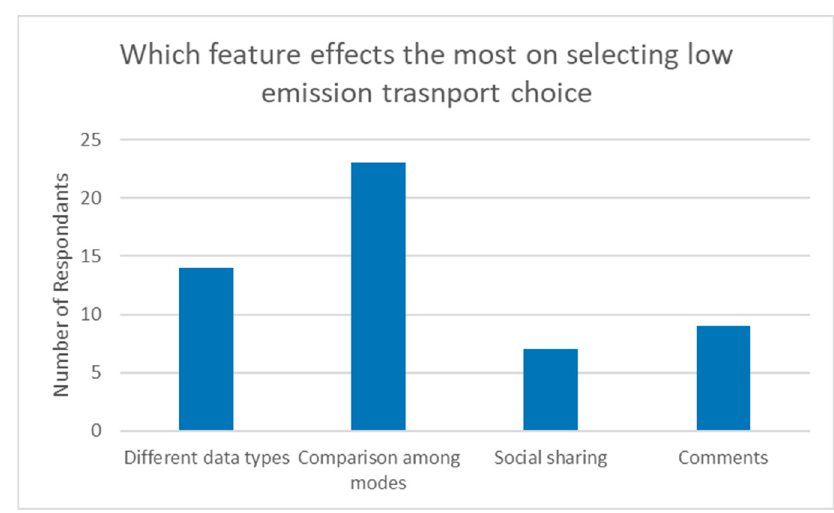
Figure 10. User view on most effective feature to promote low carbon emission vehicle choice.